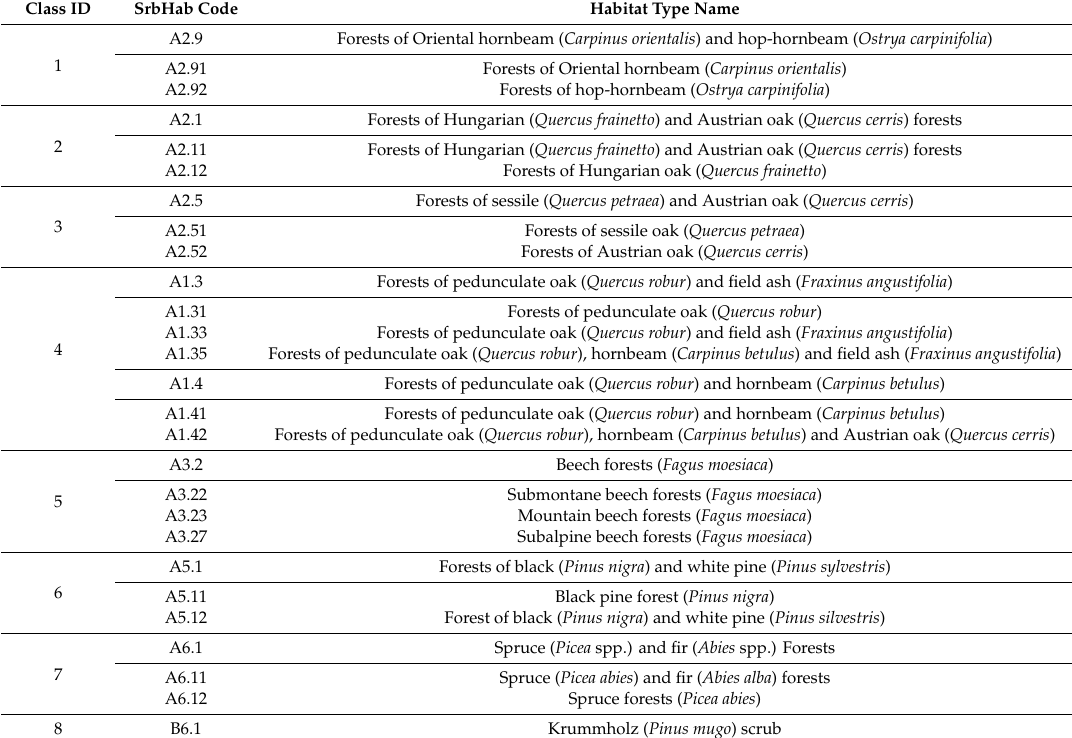
Table A1. Analyzed types of forests and shrubs according to the national classification of habitats in Serbia.